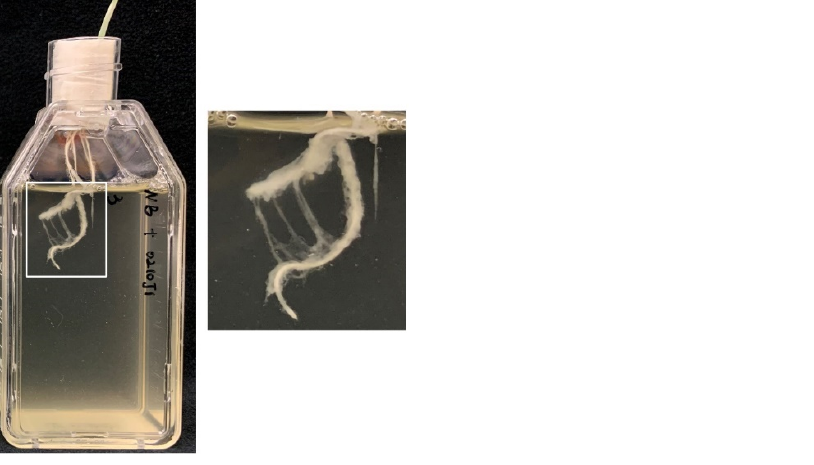
Figure 6. A representative image showing the visible biofilm formed by the Paenibacillus sp. strain S02 on the root surface of barley seedlings after three hours of co-incubation.